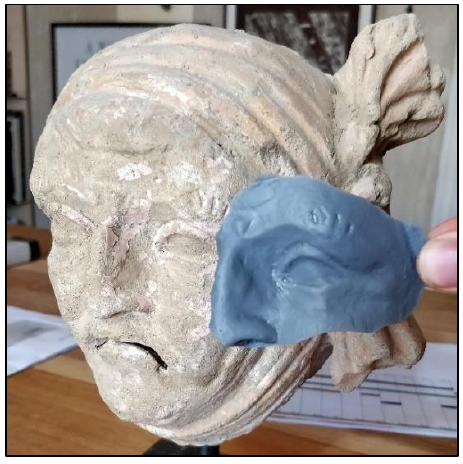
Figure 14. 3D printed segment compared to